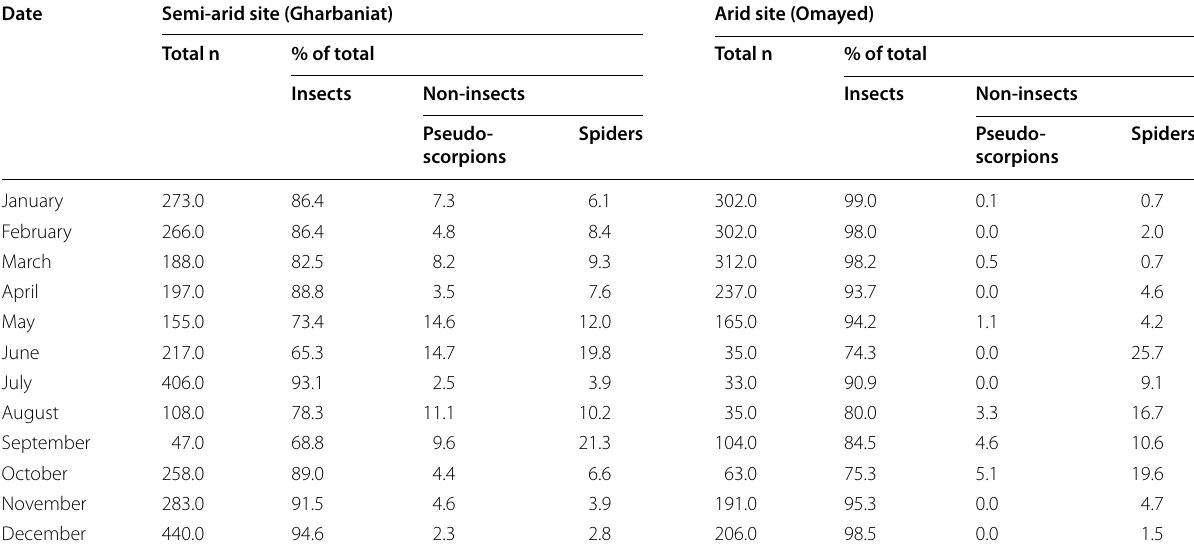
Table 1 Monthly variations in population density of insect, pseudoscorpion and spider fauna in Thymelaea hirsuta samples at two different natural sites in the EgyptianWestern Desert, in 1990